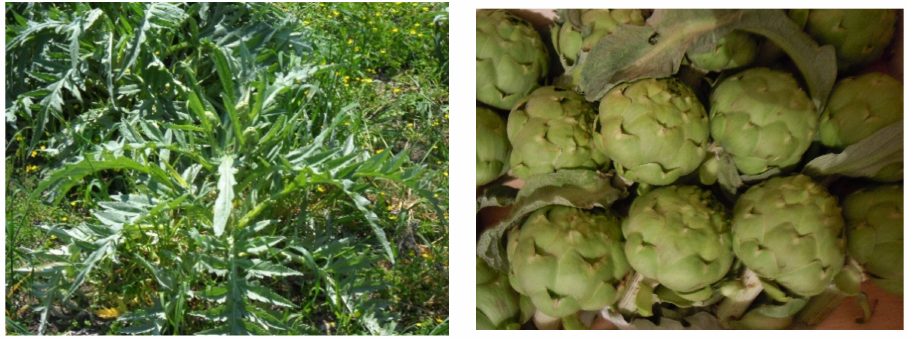
Figure 2. The artichoke Bianco of